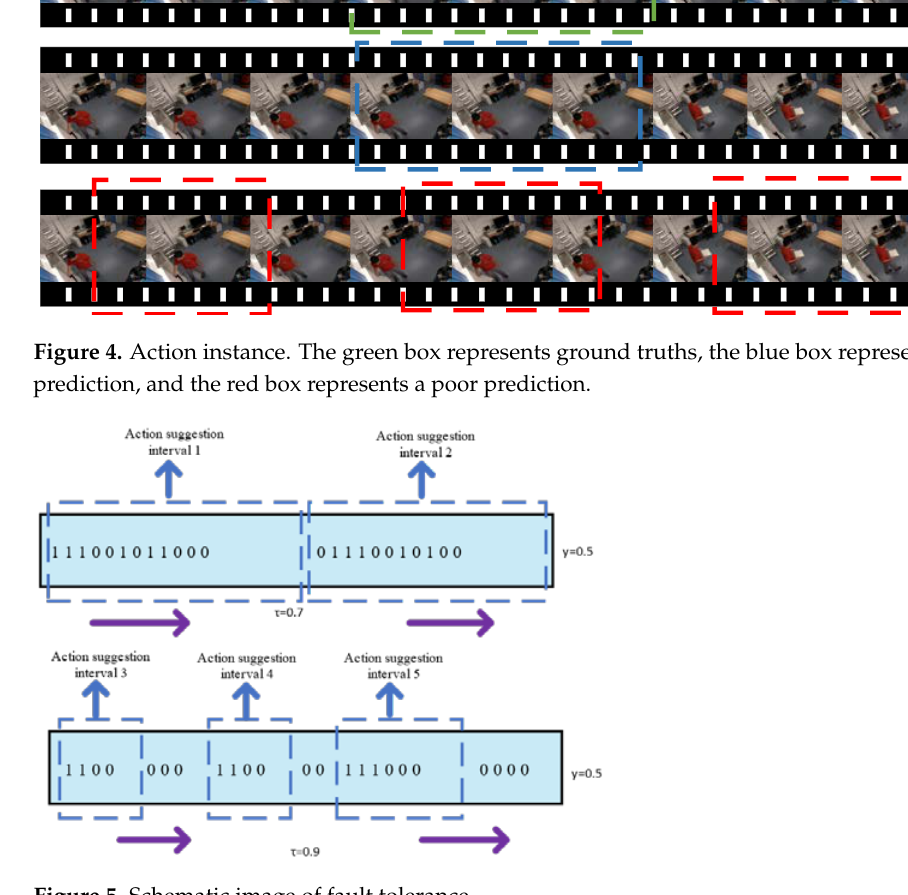
Figure 4. Action instance. The green box represents ground truths, the blue box represents a good prediction, and the red box represents a poor prediction.